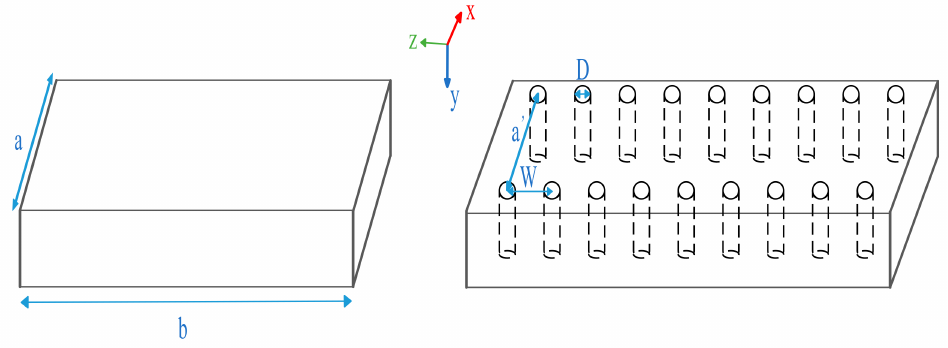
Figure 4. Traditional rectangular waveguide and simple SIW rectangular